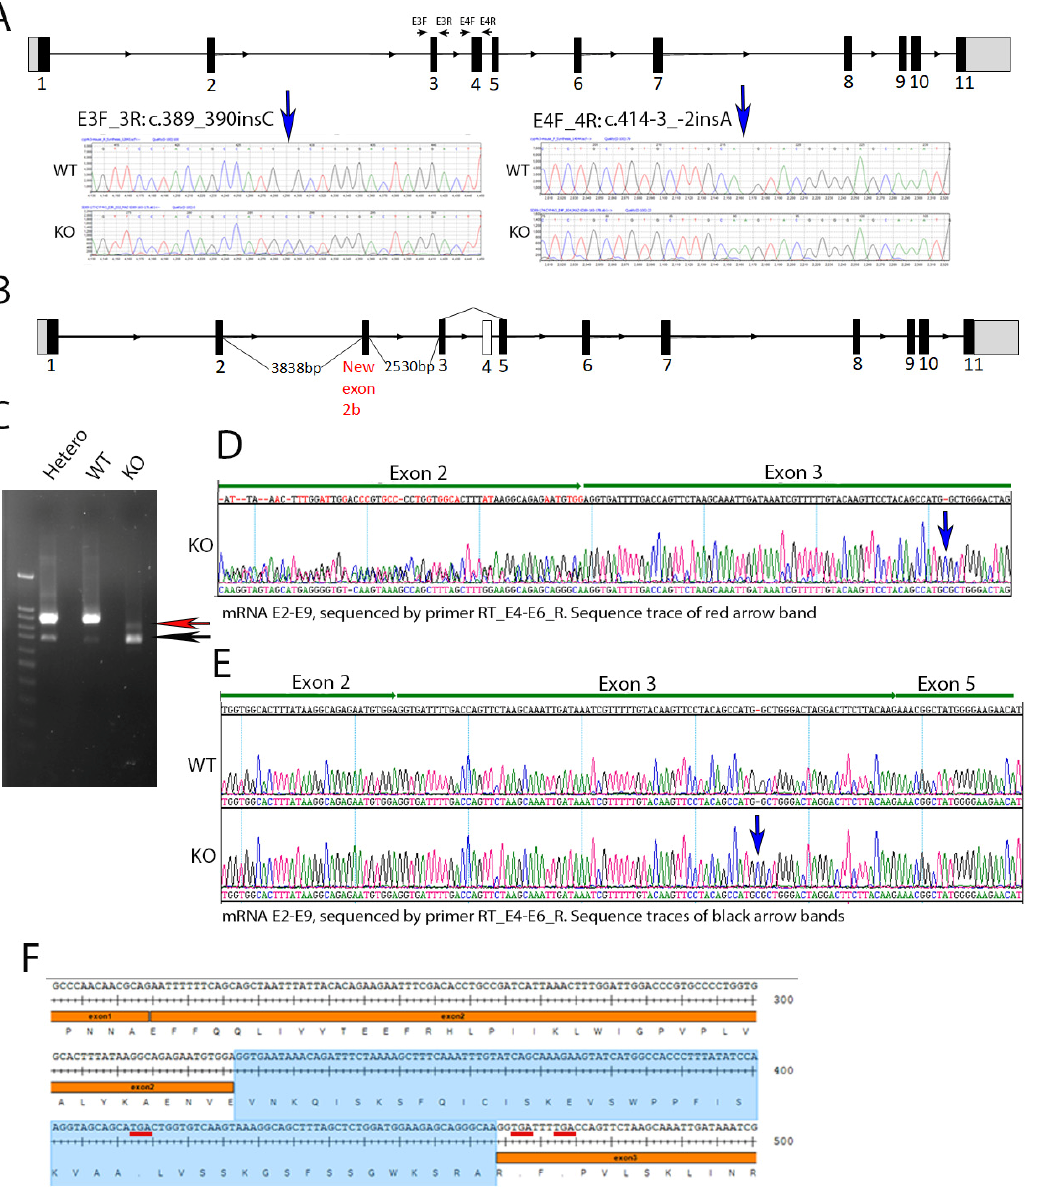
Figure 1. Cyp4v3 gene structure, mutations, and expression in the KO mouse model. ( A ). Schematic of the mouse Cyp4v3 gene showing primers used for amplification and sequence tracing, as shown for the two insertions induced in the Cyp4v3 gene. ( B ). Novel transcript and associated gene structure in KO mice, including an extra 137 bp exon (labeled 2b) between exons 2 and 3 and skipped exon 4. ( C ). RT-PCR of Cyp4v3 mRNA spanning exons 2 to 9. The red arrow indicates the novel transcript band, including exon 2b, with reverse sequencing results shown in ( D ), with dual sequences of exons 2 and 2b in the region marked exon 2. The black arrow indicates the band for the transcript skipping exon 4, which is present in both the KO and, to a lesser extent, the wild-type sequences, the sequence trace of which is shown in ( E , F ). The exact sequence for the novel transcript in the KO mice with the exon 2b sequence (shaded blue) and TGA codons (underlined in red), showing the premature stop codons in exons 2b and